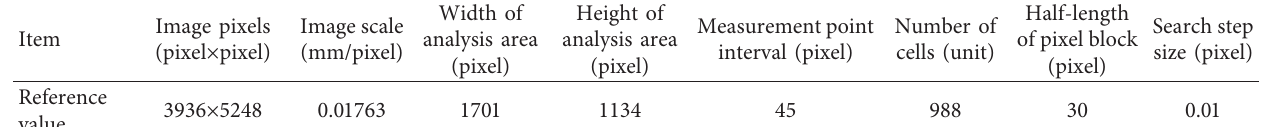
Table 4: Image analysis parameters used in PhotoInfor.